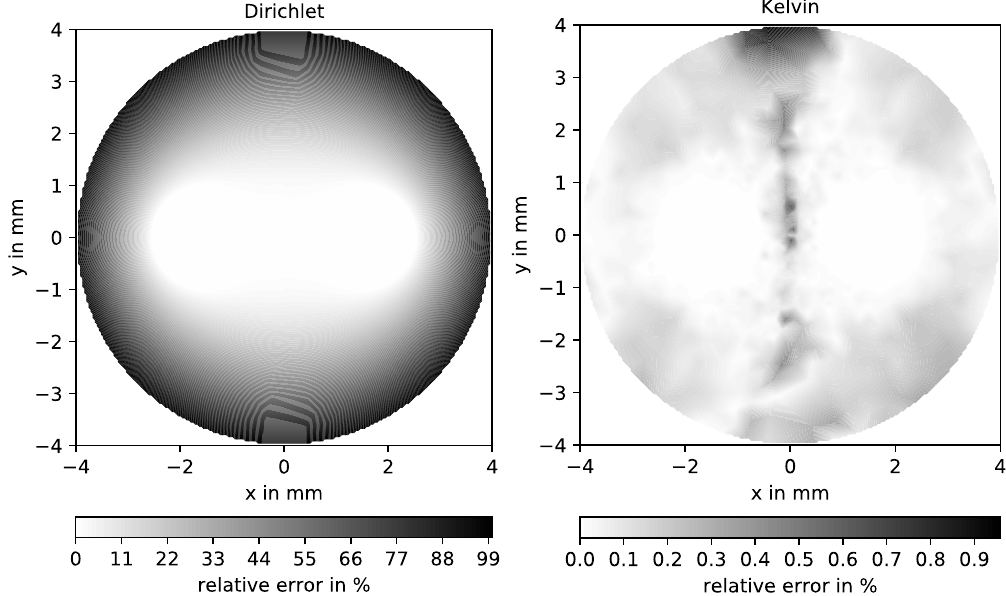
Figure 8. Relative error of Φ for a Dirichlet ( left ) and Kelvin boundaries ( right ). Note the different scales in both diagrams.